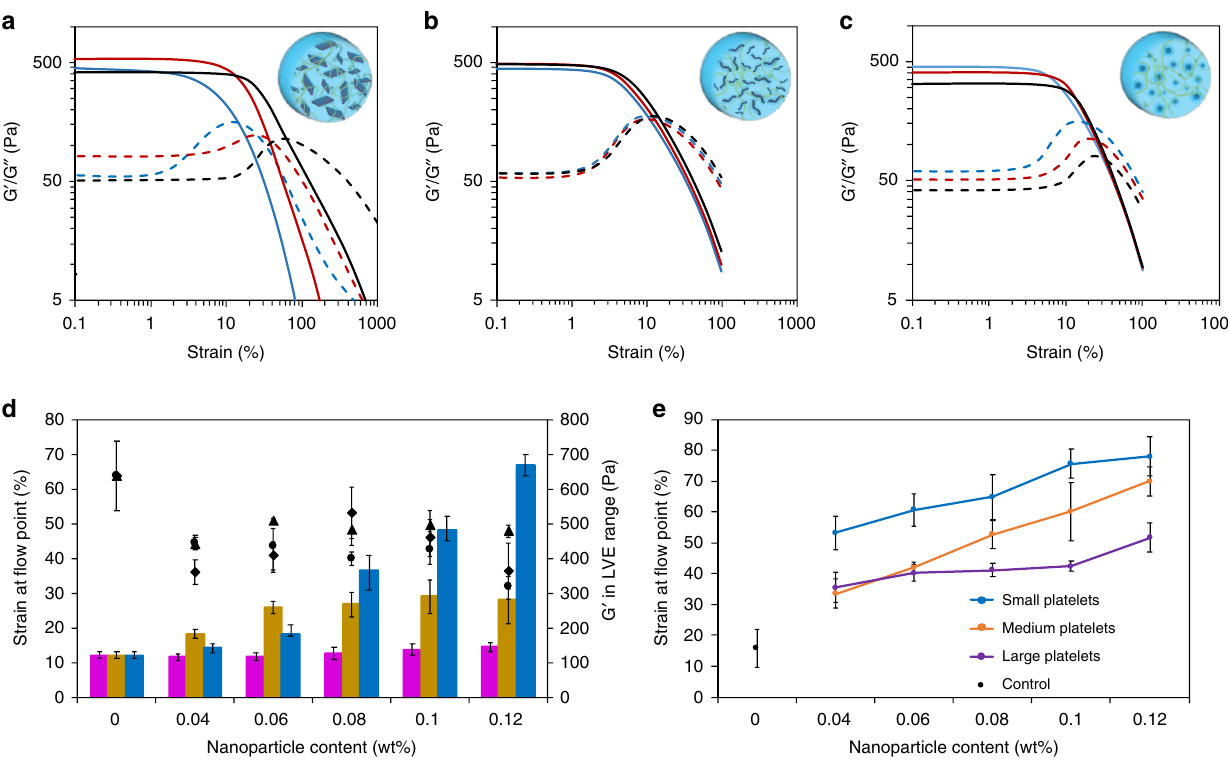
Fig. 3 Rheological properties of calcium-alginate hydrogels enriched with PLLA 35 -based nanoparticles of different morphologies. Strain-dependent oscillatory rheology measurements showing storage modulus (G ′ , solid line) and loss modulus (G ″ dashed line) of NC calcium-alginate hydrogels with 0.04 (blue), 0.08 (red), and 0.12 wt% (black) platelets (1124 × 676 nm) a , cylindrical b , and spherical micelles c . d Comparison of strain at the fl ow point ( Y -axis, left) and G ′ in the linear viscoelastic region ( Y -axis, right) for NC hydrogels incorporating platelets (blue bar for G ′ , ♦ for strain at fl ow point), spherical (dark yellow bar, • ), or cylindrical micelles (magenta bar, ► ) at different wt% ( X -axis). e Comparison of strain at the fl ow point between different sizes of platelets (small: 372 × 223 nm, medium: 893 × 528 nm, and large: 1700 × 993 nm) as a function of the total surface area. Error bars represent the standard deviation of the data. Statistical analysis of these data can be found in Supplementary Tables 9 and